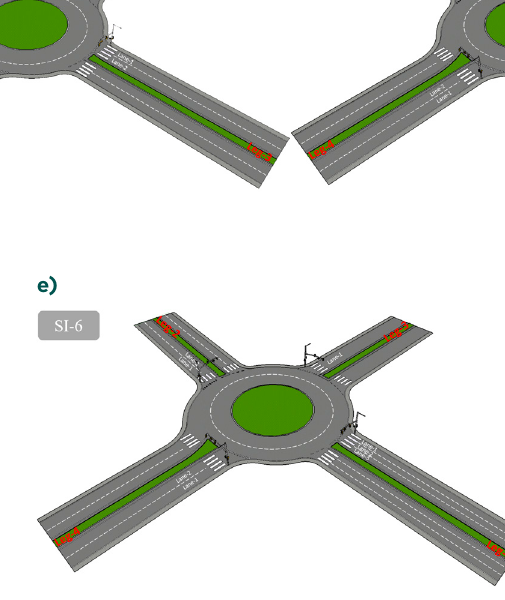
Figure 3. Schematic layout of signalized intersections: (a) SI 1-2, (b) SI 3, (c) SI 4, (d) SI 5, and (e) SI